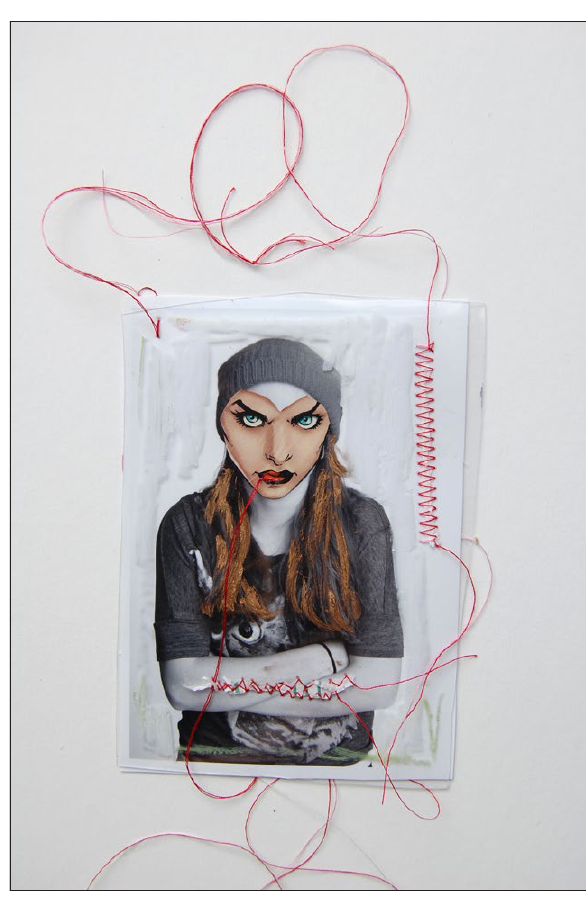
Figure 1: Brain Candy: Persona,